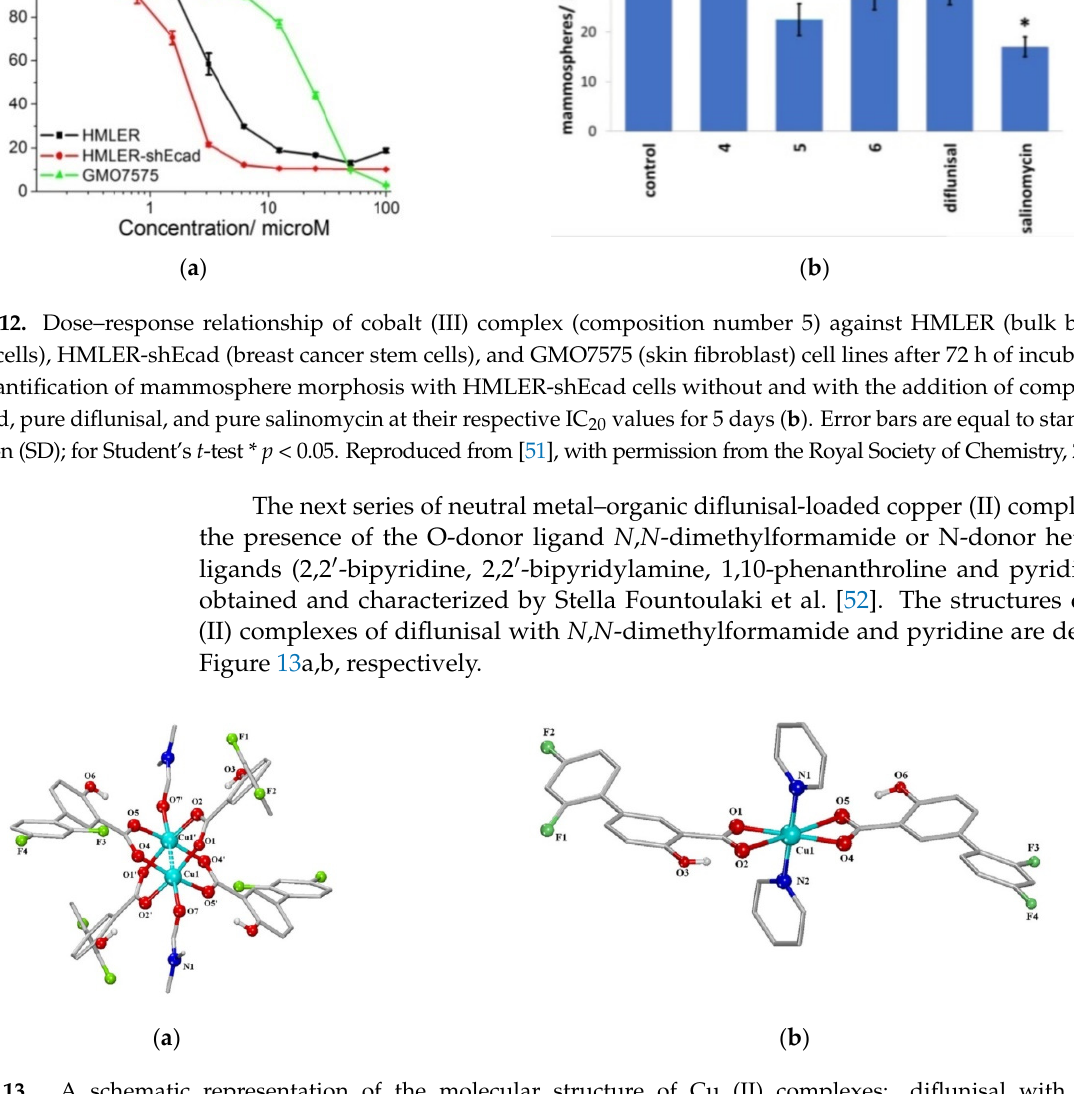
Figure 13. A schematic representation of the molecular structure of Cu (II) complexes: diflunisal with N,N-dimethylformamide ( a ); diflunisal with pyridine ( b ). Reproduced from [52], with permission from Elsevier, 2021.